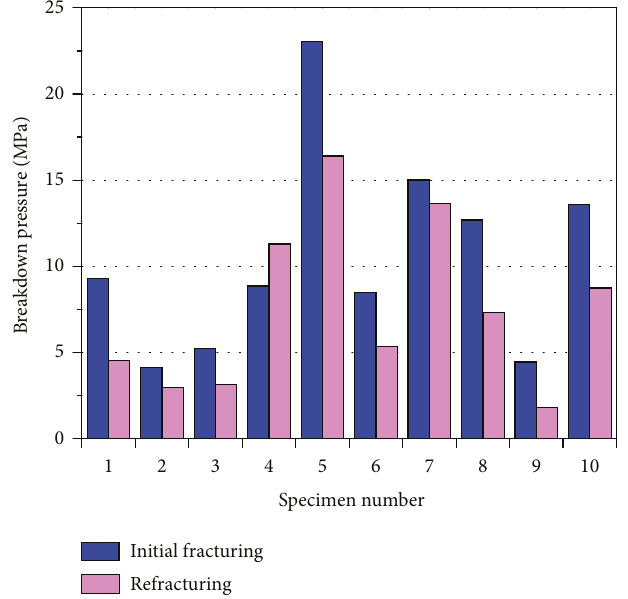
Figure 8: Comparison of breakdown pressure between two